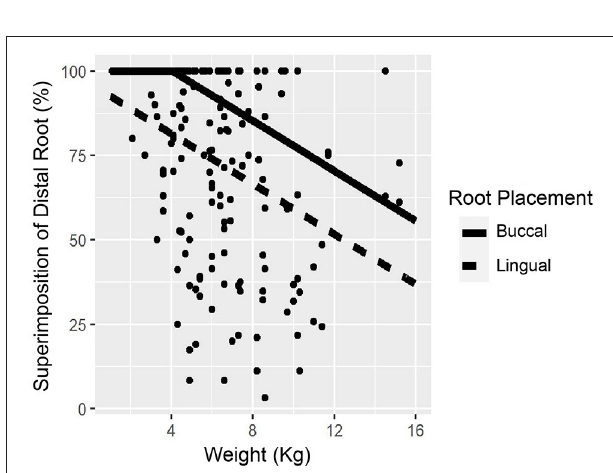
FIGURE 6 | Relationship between distal root superimposition and weight. Distal root showed 100% superimposition with the mandibular canal (MC) for patients < 4kg. The lingual located root showed a consistent 18.75% less superimposition between the two structures.